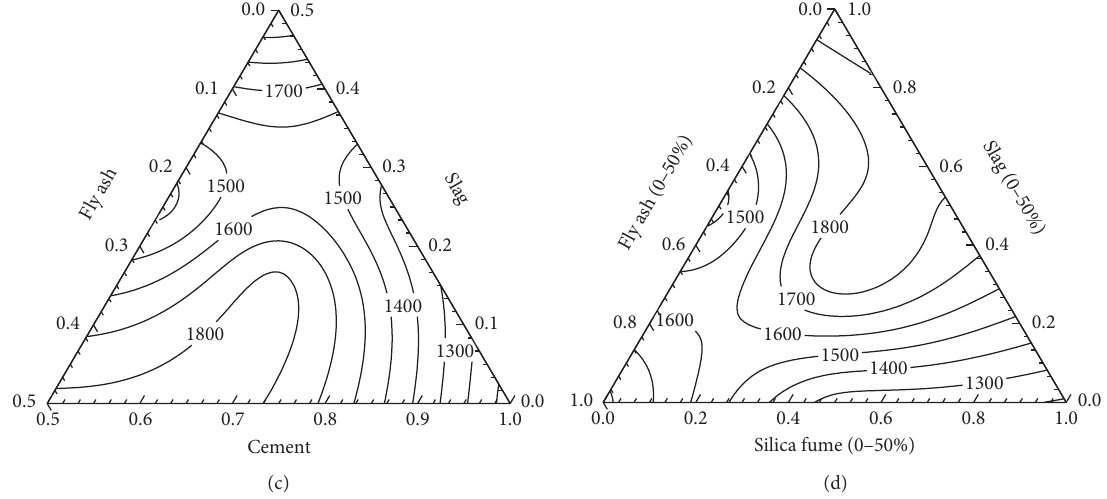
Figure 11: Autogenous shrinkage of UHPC (3d) with cement-silica fume-slag-fly ash binder